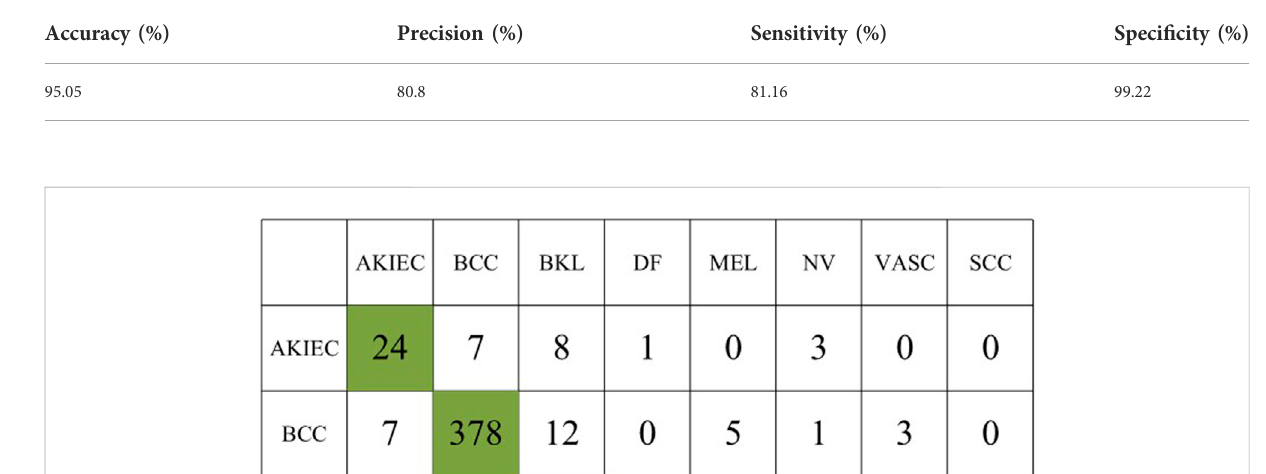
TABLE 2 Results of the fi rst experiment.